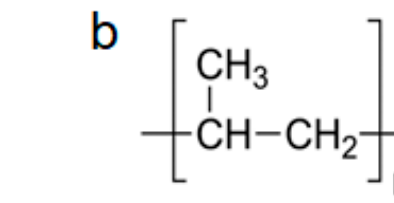
Figure 1. Chemical structure of ( a ) polyethylene and ( b ) polypropylene.